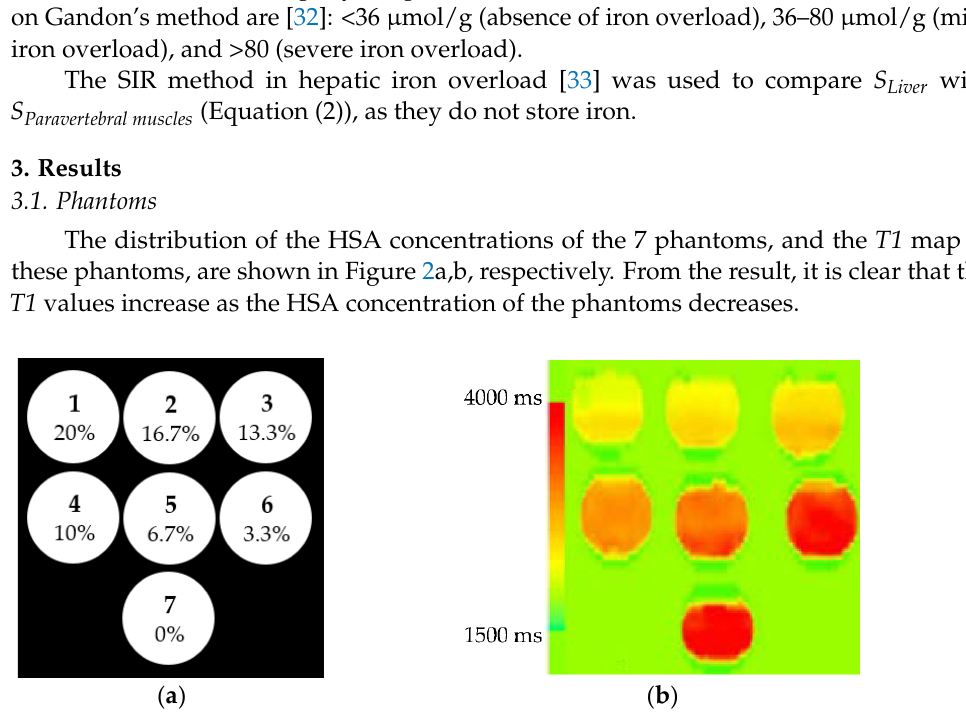
( b ) Figure 4. T1 maps of patient #1 ( a ) and patient #2 ( b ) acquired at 3T. There are 3 ROIs in the liver following Couinaud’s segments IV (1), VIII (2) and VII (3). T1 values for patient #1 are 750.88 ms ± 7.95 ms (mean ± standard deviation): ROI 1, 797.48 ± 66.59 ms; ROI 2, 766.20 ± 49.72 ms; ROI 3, 688.96 ± 66.6 ms. While for patient #2 they are 882.92 ms ± 3.84 ms (mean ± standard deviation): ROI 1, 889.09 ± 44.84 ms; ROI 2, 829.30 ± 50.34 ms; ROI 3, 930.37 ± 54.27 ms. 3.3. Steatosis Fat-only images (Figure 5(a.1,b.1,c.1,d.1)) and water-only images (Figure 5 (a.2,b.2,c.2,d.2)) allow the calculation of the FF (%) (Equation (1)) at 3T and 1.5T. The re- sults of the different grades of steatosis show the hyperintensity of the liver when the severity of the disease increases in fat-only images. 0 ms 2000 ms